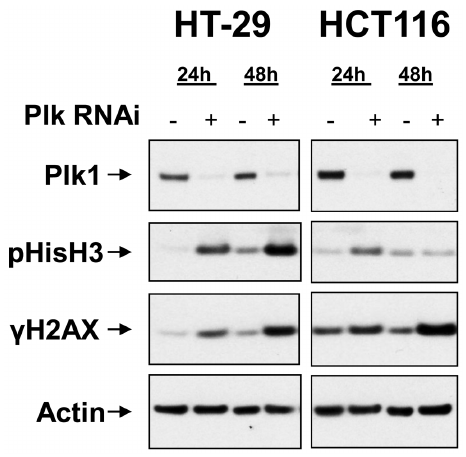
Figure 3. RNAi (10 nM final concentration) directed against Plk1 leads to mitotic arrest followed by increased DNA damage. In HT-29 cells, a prolonged mitotic arrest (pH3) is followed by an increase in DNA damage ( c H2AX). In HCT116 cells, transient mitotic arrest (pHisH3) is followed by an increase in DNA damage ( c